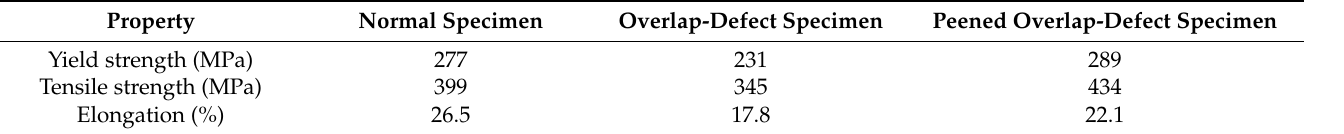
Table 2. Tensile test results of each specimen.